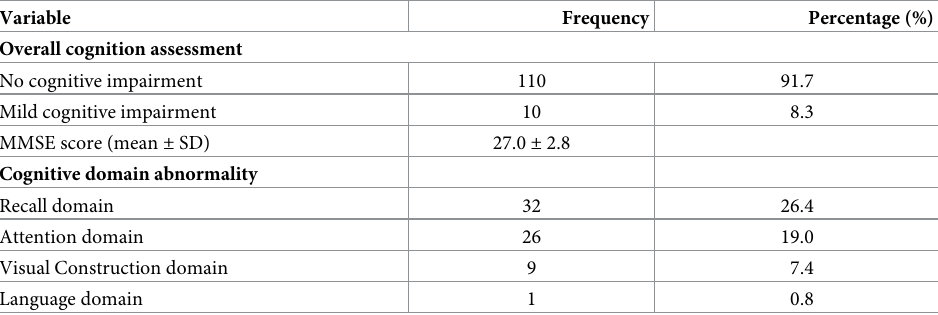
Factors associated with peripheral neuropathy In multivariate analysis, age (cid:21) 55 years (AOR: 6.25, 95%CI: 1.33–29.08, p = 0.02) and longer duration of illness (AOR: 1.01, 1.00–1.02, p = 0.01) were identified as factors independently associated with peripheral neuropathy (Table 10). Table 5. Cognitive assessment